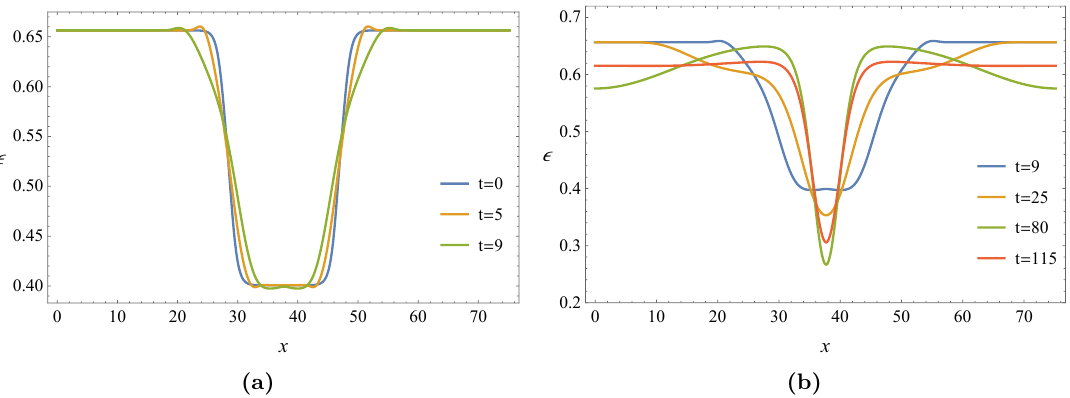
Figure 6. The energy density at different times in the process where the system converges to the critical solution. The parameter δ , which characterizes the length of the nucleus, is fixed to 3 π , and parameter α is set to 0 . 8 L x to maintain the smoothness of the